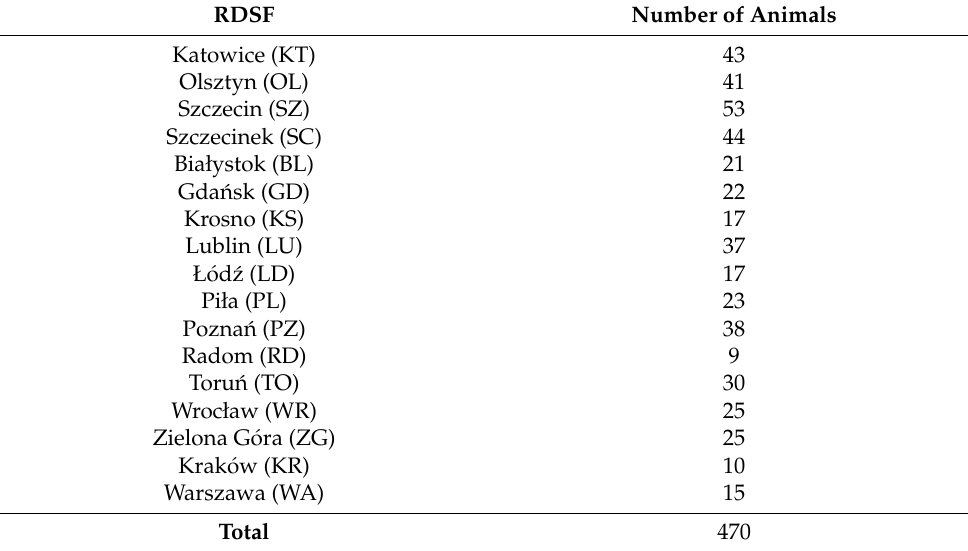
Table 1. The inhabiting area and the number of tested wild boars in particular RDSFs in Poland. RDSF Number of